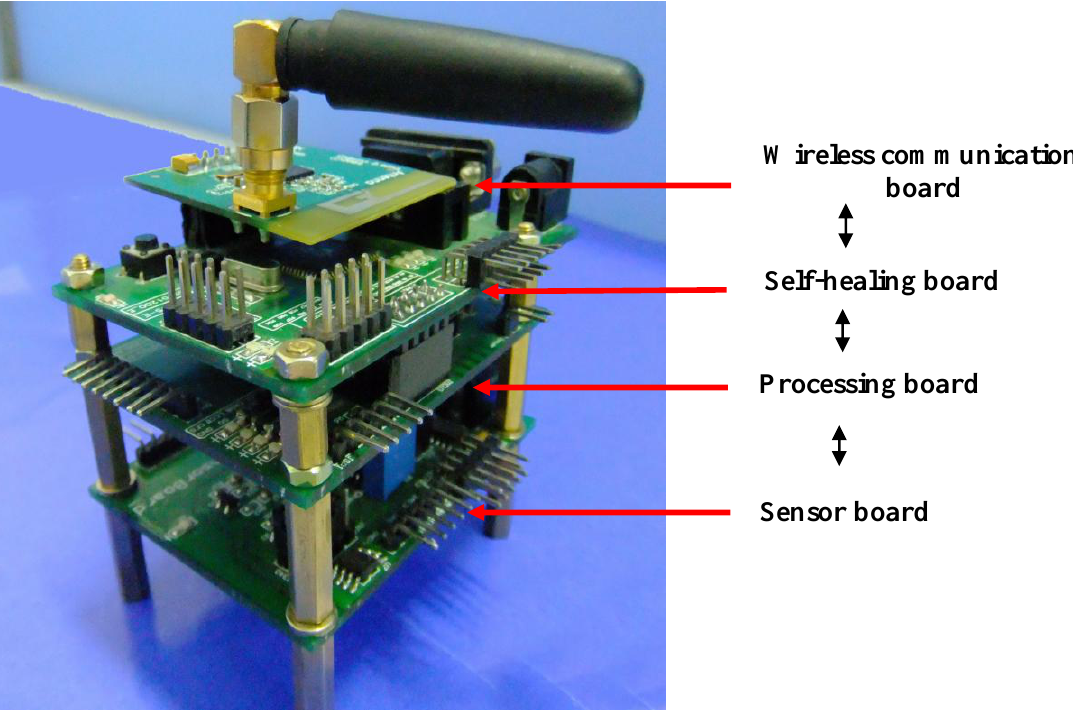
Figure 7. Redundancy-based self-healing WSN strain node